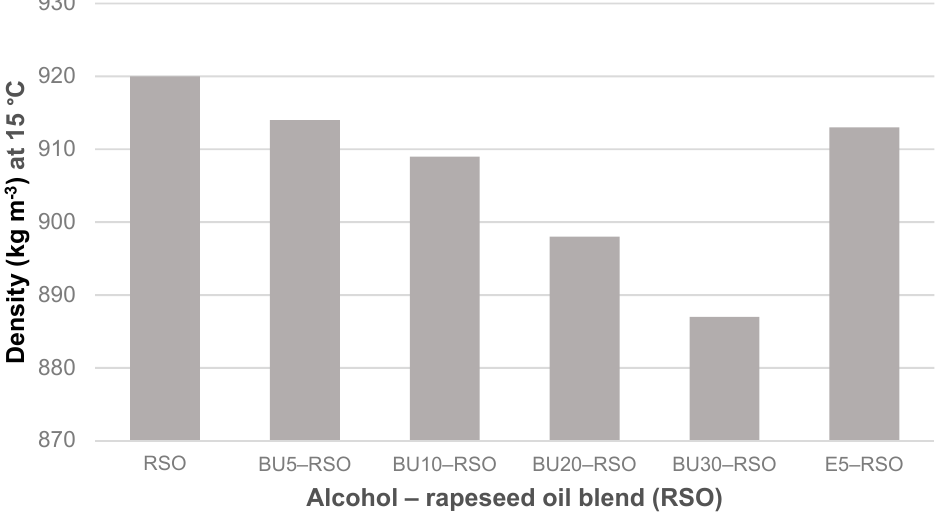
Figure 2. Kinematic viscosity measured at 40 °C for rapeseed oil, butanol ‒ rapeseed oil and ethanol ‒ rapeseed oil blends.